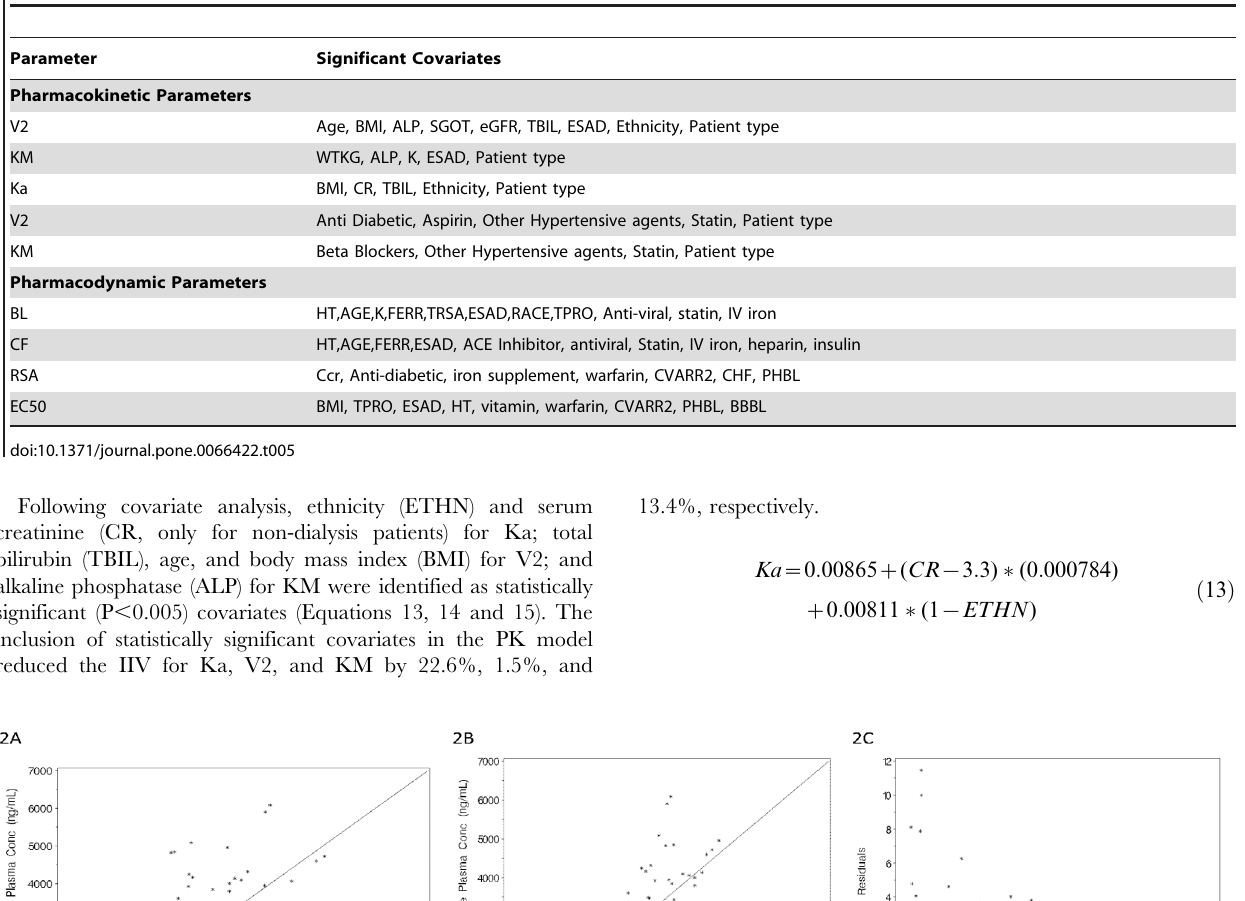
Table 5. Covariates evaluated on the PK and PD parameters of peginesatide in NONMEM using forward selection and backward elimination approach.